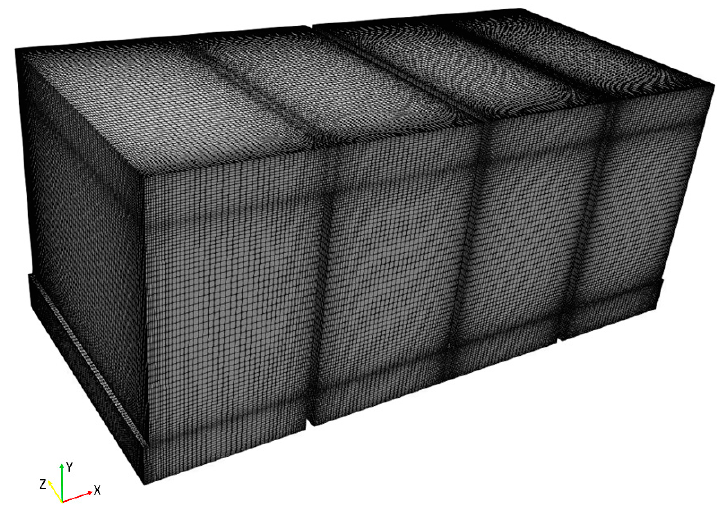
Figure 2. Three-dimensional view of the structural mesh.